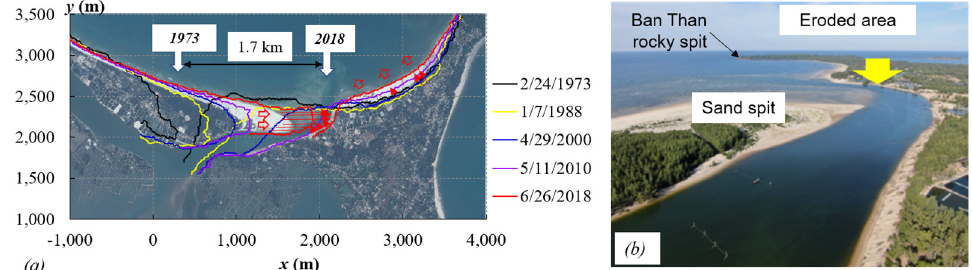
Figure 3. ( a ) Cua Lo sand spit elongation over period 1973–2018, ( b ) location of the elongated sand spit and eroded area.